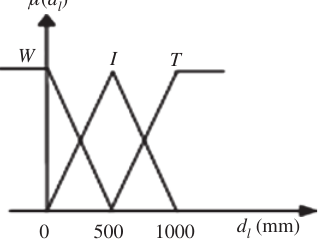
Figure 8: Membership Functions for the Left Distance.